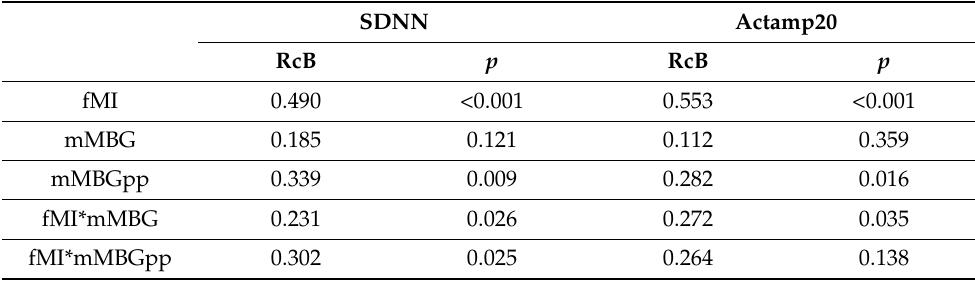
Table 4. Results of the general estimating equation (GEE) analysis regarding the associations between fetal movement index (fMI), mean maternal blood-glucose (mMBG), mean one-hour post prandial maternal blood-glucose levels (mMBGpp) during the seven days prior to fMCG recording, and the respective interaction terms fMI*mMBG and fMI*mMBGpp to the parameters SDNN and Actamp20 in the study cohort: regression coefficients of Beta